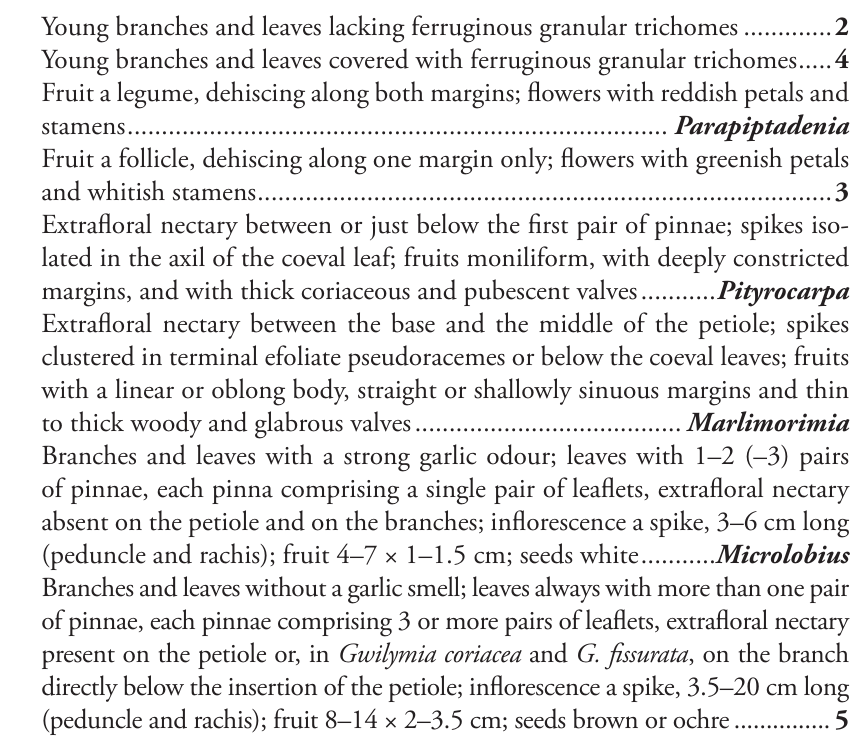
Key to the genera of the Stryphnodendron clade (sensu Koenen et al. 2020, Ringelberg et al. 2022, Borges et al. 2022)